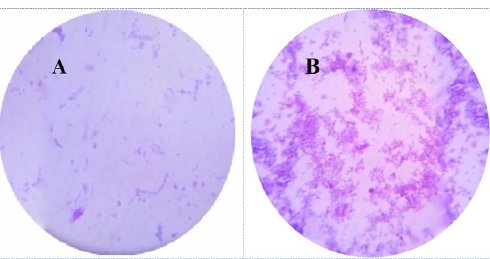
Fig. 8. Photographs showing the antifouling effect of AgNPs synthesized by Pseudomonas sp . H64 on biofilm formation (A), Control (without AgNPs)